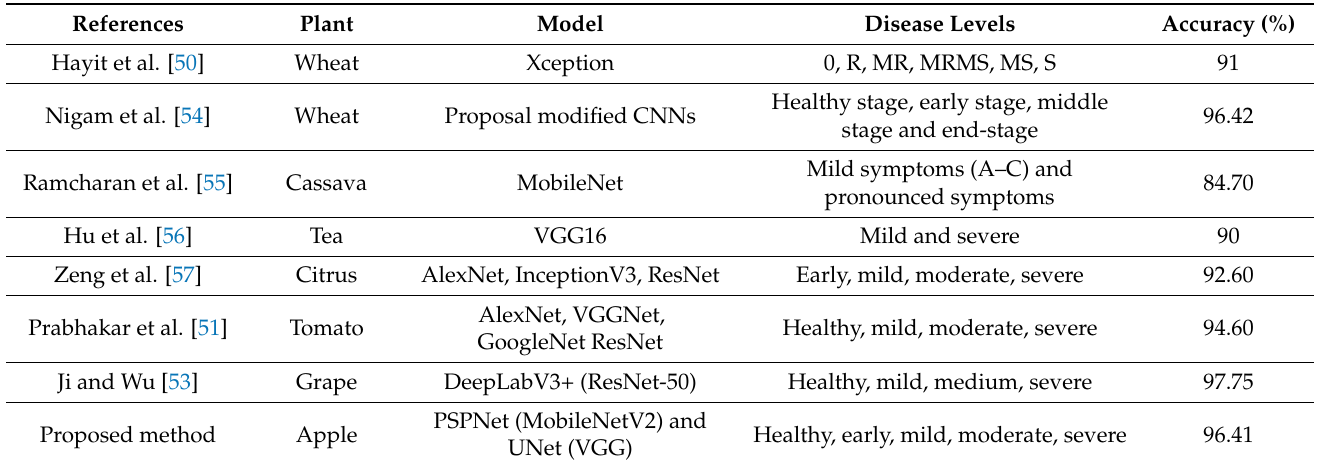
Table 5. A summary of plant disease-severity evaluation based on different CNN